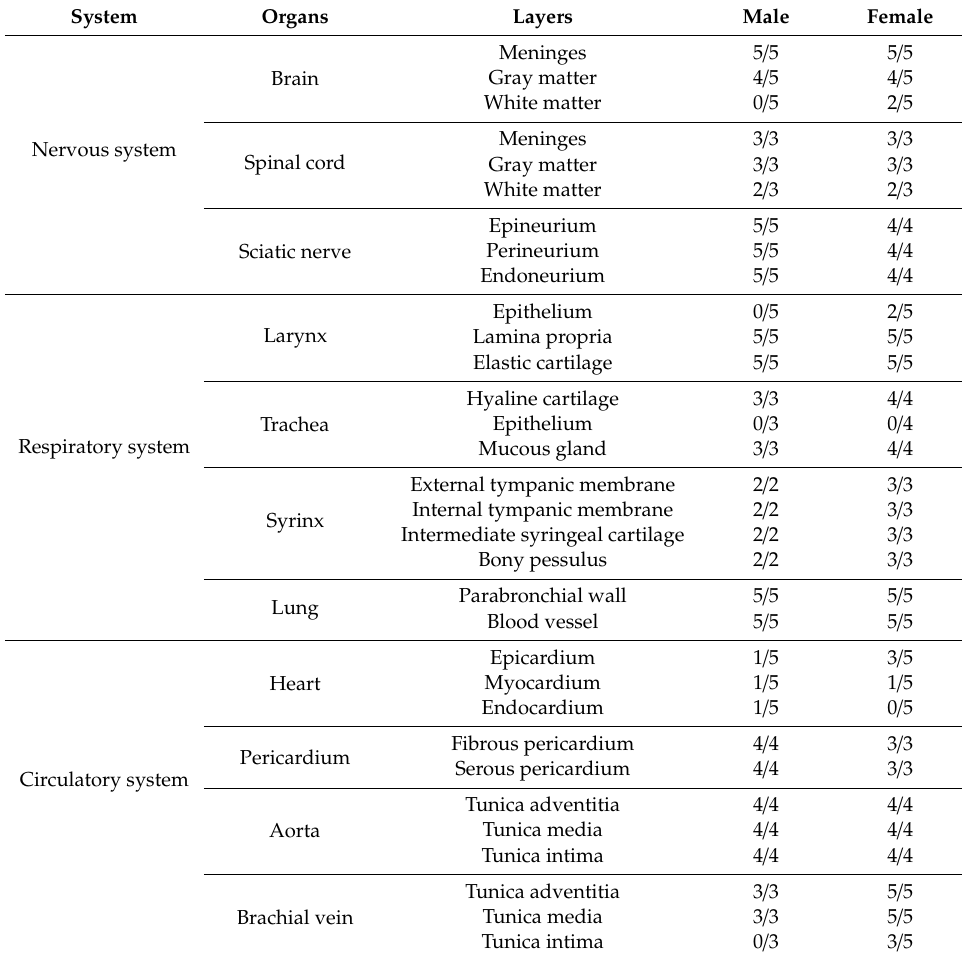
Table 1. Detection of melanin pigment present in each layer of all tissue samples and comparisons between male and female